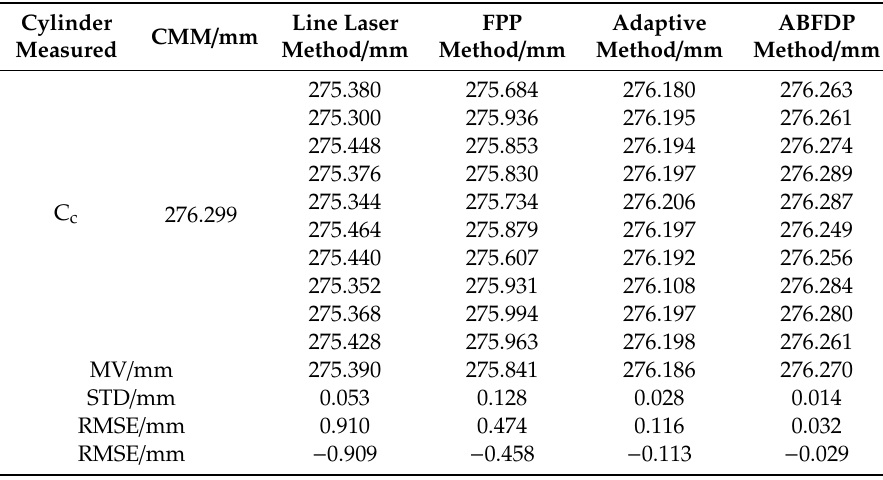
Table 4. Diameter measurement results of C c with di ff erent